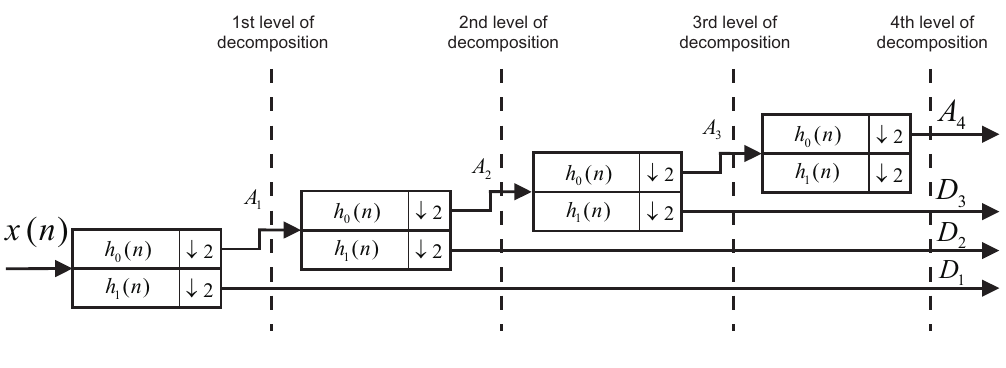
Figure 7. Filter banks of the discrete wavelet transform.